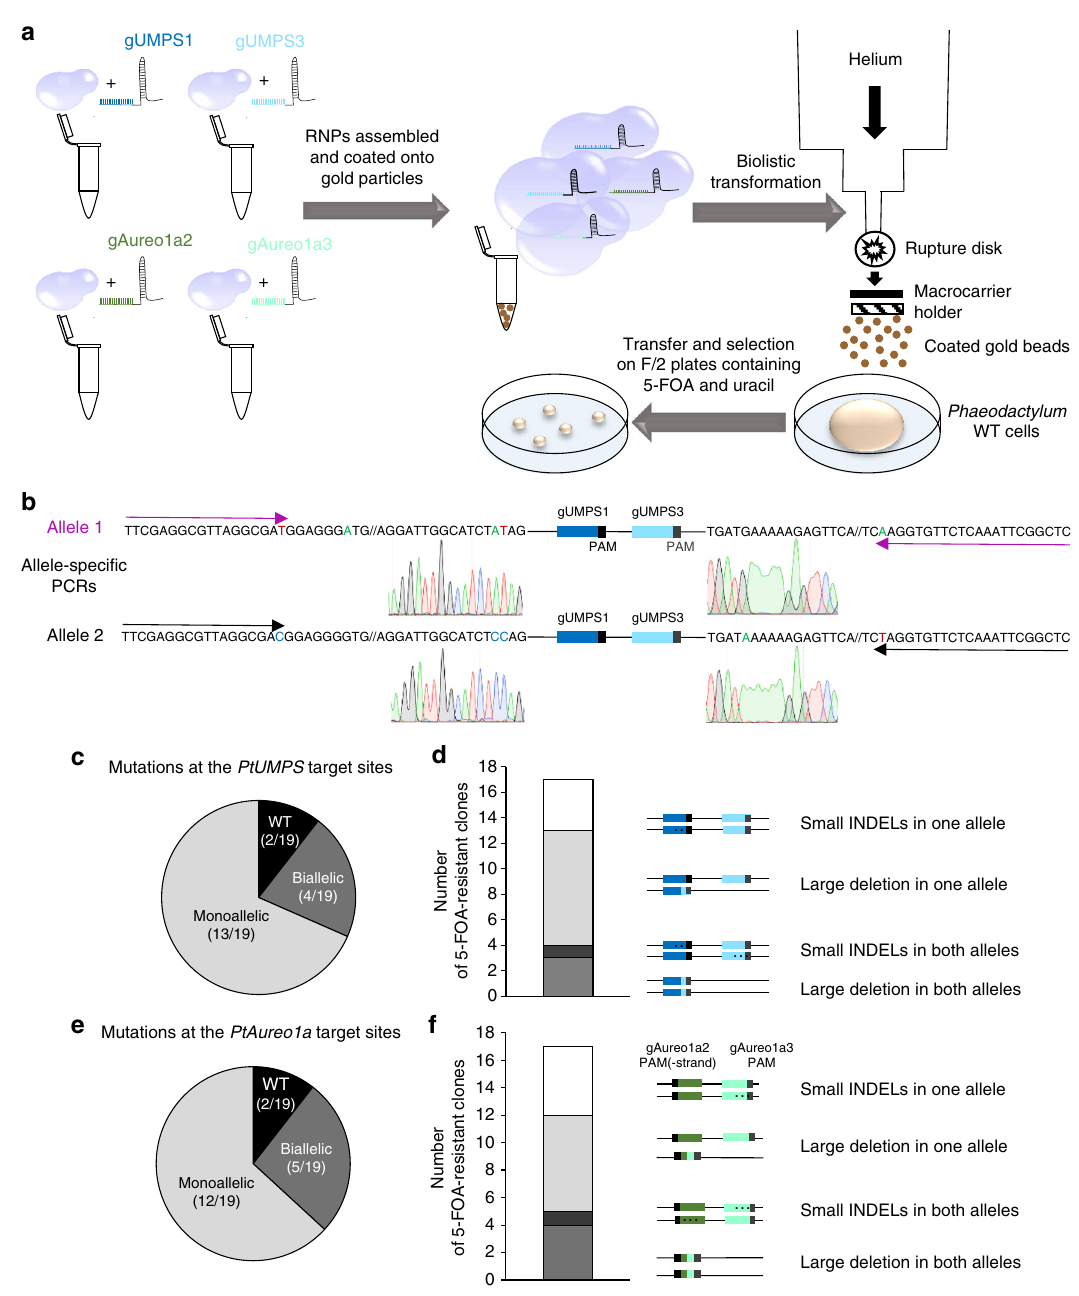
Fig. 3 Multiple gene knock-outs using a DNA-free RNP genome editing approach. a Outline of the genome-editing work fl ow used here. The fi rst step consists of generating four independent RNP complexes, two of them targeting PtUMPS and the two others targeting PtAureo1a or any other gene of interest. Each RNP complex is prepared in a separate tube by incubating the Cas9 protein with pre-annealed crRNA::tracrRNA complexes (crRNA: base pairing site, tracrRNA: trans-activating crRNA). Next, the four RNP complexes are combined and loaded onto gold particles. The third step consists of the delivery of these coated gold beads into Phaeodactylum cells using a biolistic apparatus. Finally, after two to four days, the transformed cells are re-plated onto selective medium, here F/2 medium supplemented with uracil and 5-FOA. After three to four weeks, 5-FOA-resistants colonies appear and are analyzed for the presence of mutagenic events. b Each allele of the PtUMPS gene was ampli fi ed by allele-speci fi c PCRs from the obtained 5-FOA resistant colonies and sequenced. c Frequency of colonies harboring no mutagenic event at the PtUMPS loci (black sector on the pie chart) or a mutagenic event on one allele (light gray sector) or both alleles (dark gray sector). d Additional information on the nature of the mutagenic events is reported, with four classes of mutagenic events being illustrated: small INDELs in one allele, the second being WT (white bar); large deletion corresponding to the DNA sequence between the two targeted sites in one allele, the second allele being WT (light gray bar); small INDELs in both alleles (dark gray bar); deletion of the DNA fragment between the two targeted sites in both alleles (medium gray bar). e Frequency of targeted mutagenesis of the PtAureo1a target sites (black sector: no TM detected, light gray sector: monoallelic mutants, dark gray sector: biallelic mutants). All clones mutated in PtUMPS also carried a mutation in at least one of the PtAureo1a alleles. f Distribution for the various classes of mutagenic events at the PtAureo1a